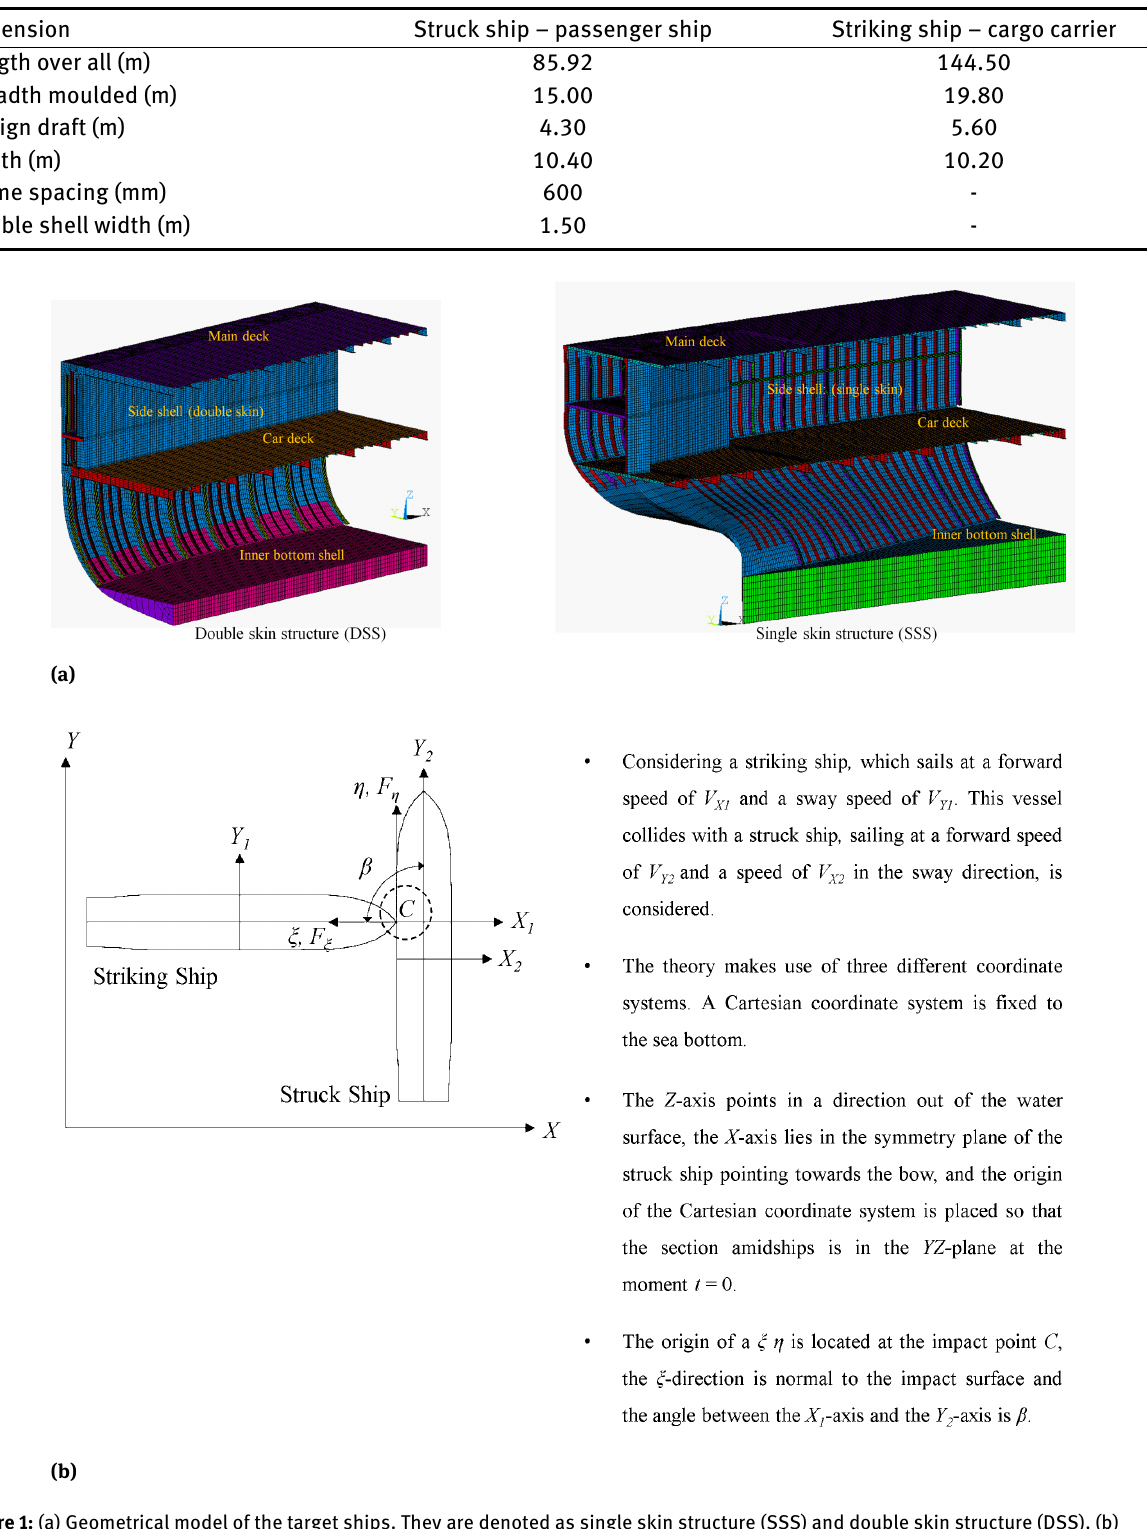
Figure 1: (a) Geometrical model of the target ships. They are denoted as single skin structure (SSS) and double skin structure (DSS). (b) Simplified coordinate system for ship collision based on analytical theory diagram of ship collision by Zhang